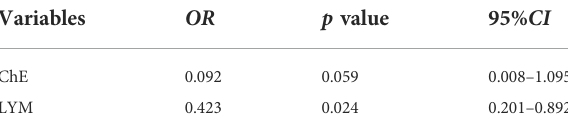
TABLE 4 Baseline data multivariate logistic regression